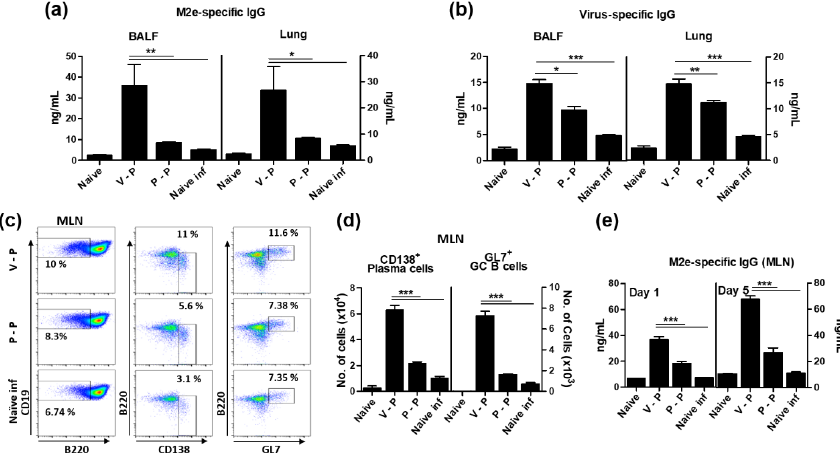
Figure 3. 5xM2e VLP-primed but not protein-primed immune sera confer cross-protection against rgH5N1 virus. Mice ( n = 3) were intranasally infected with a high lethal dose (10× LD 50 ) of reassortant rgH5N1 (A/VN1203 (rgH5N1)) virus mixed with each immune serum collected at three weeks after boost immunization. Body weight changes were monitored for 14 days. ( a , b ) Body weight changes and survival rates. Naïve: naïve mice infected with influenza virus, V-P: VLP prime/protein boost, P-V: protein prime/VLP boost, P-P: protein prime boost, V-V: VLP prime boost. The statistical significance was confirmed by two-way ANOVA. Error bars indicate the means ± SEM of concentration from individual animals. *; p < 0.05, **; p < 0.01 in comparison to V-P and P-P, # ; p < 0.05, ## ; p < 0.01 in comparison to V-P and naïve.